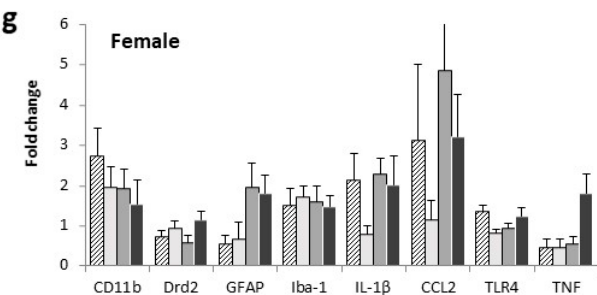
Figure 3. Gene expression in the hippocampus; ( a ) Saline- and lipopolysaccharide (LPS)-injected male mRNA levels of CD11b and Drd2; ( b ) saline- and LPS-injected male mRNA levels of IL-1 β and TLR4; ( c ) saline- and LPS-injected male mRNA levels of TNF and CCL2; ( d ) Saline- and LPS-injected male mRNA levels of GFAP and Iba-1; ( e ) fold change in gene expression between LPS- and saline-injected males; ( f ) saline- and LPS-injected female mRNA levels of TLR4 and CCL2; ( g ) fold change in gene expression between LPS- and saline-injected females. Values are mean ± SEM ( n = 10–13 / group). Post hoc analysis is depicted with the superscripts a,b where groups without a common superscript di ff er ( p < 0.05) (i.e., a is di ff erent from b but ab is not di ff erent from a or b). CT: control; AB: antibiotic; PR: prebiotic; AB + PR: antibiotic plus prebiotic.